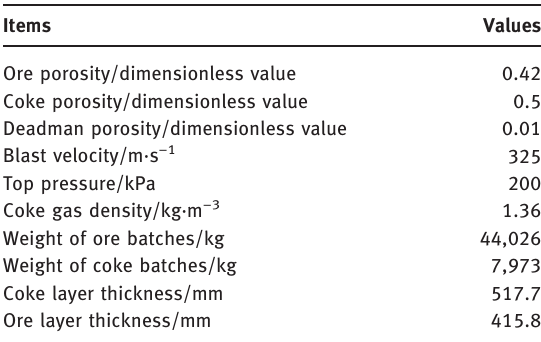
Table 3: Parameters for calculation.